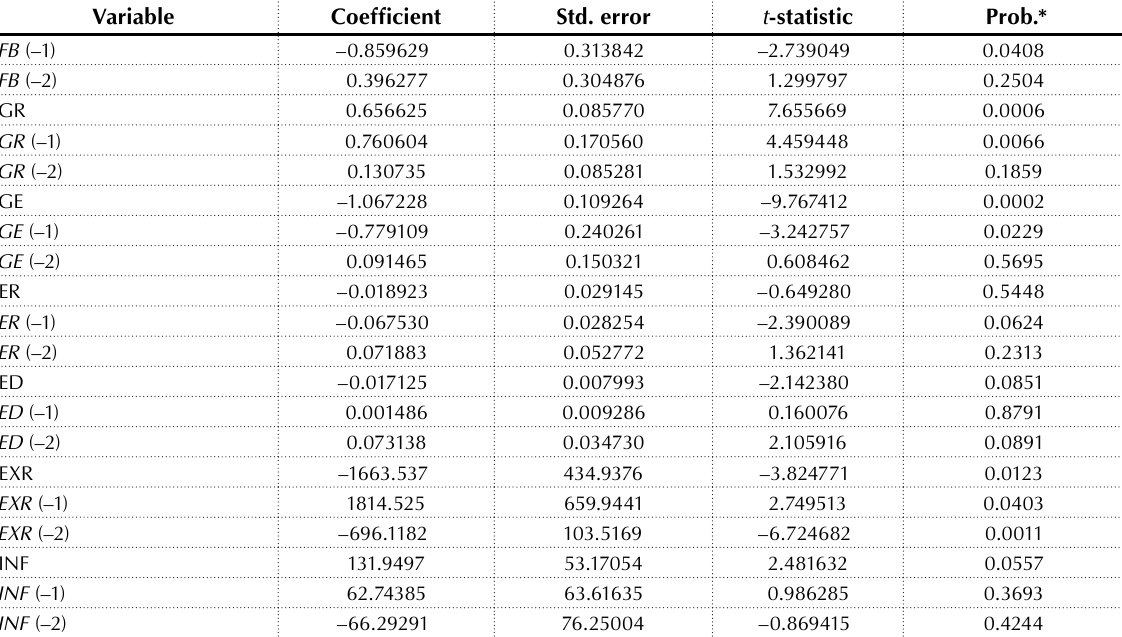
Table 14. ARDL regression for fiscal policy shocks and fiscal balance Method: